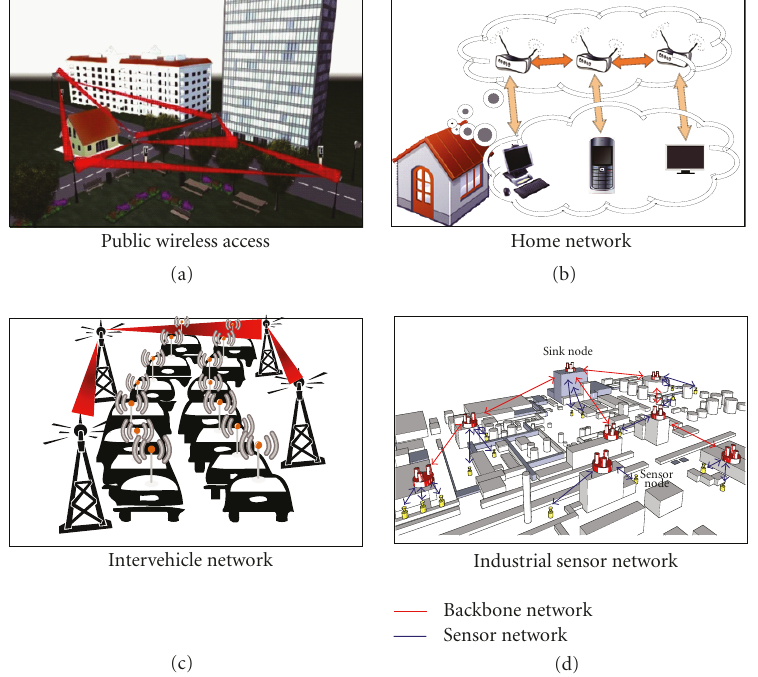
Figure 1: Some applications of the future wireless mesh